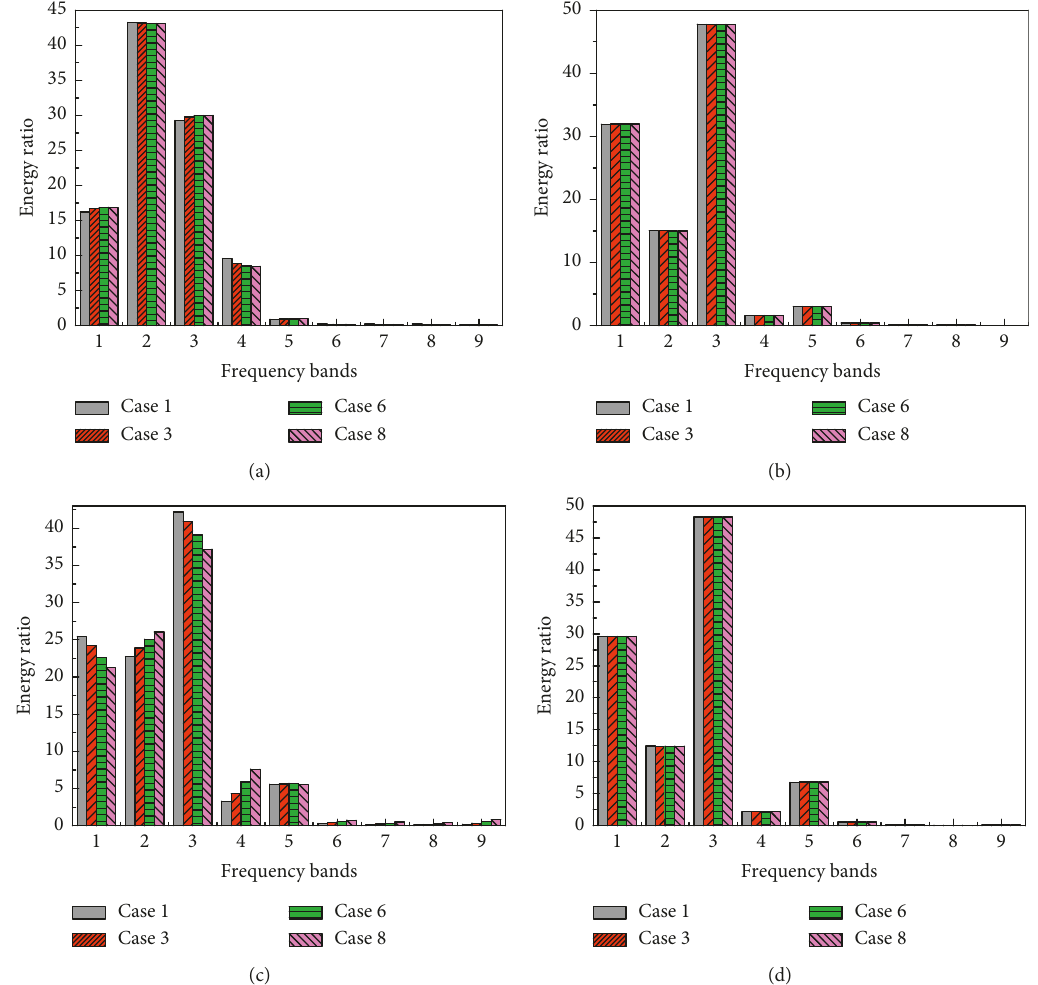
Figure 8: Hilbert marginal energy ratio spectrum in model tests (single damage). (a) Point 1. (b) Point 7. (c) Point 12. (d) Point